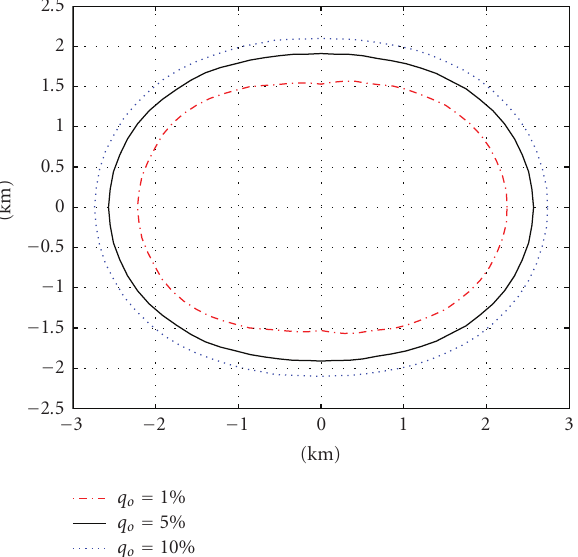
Figure 6: BC coverage area versus cell distance ( N t = 3).